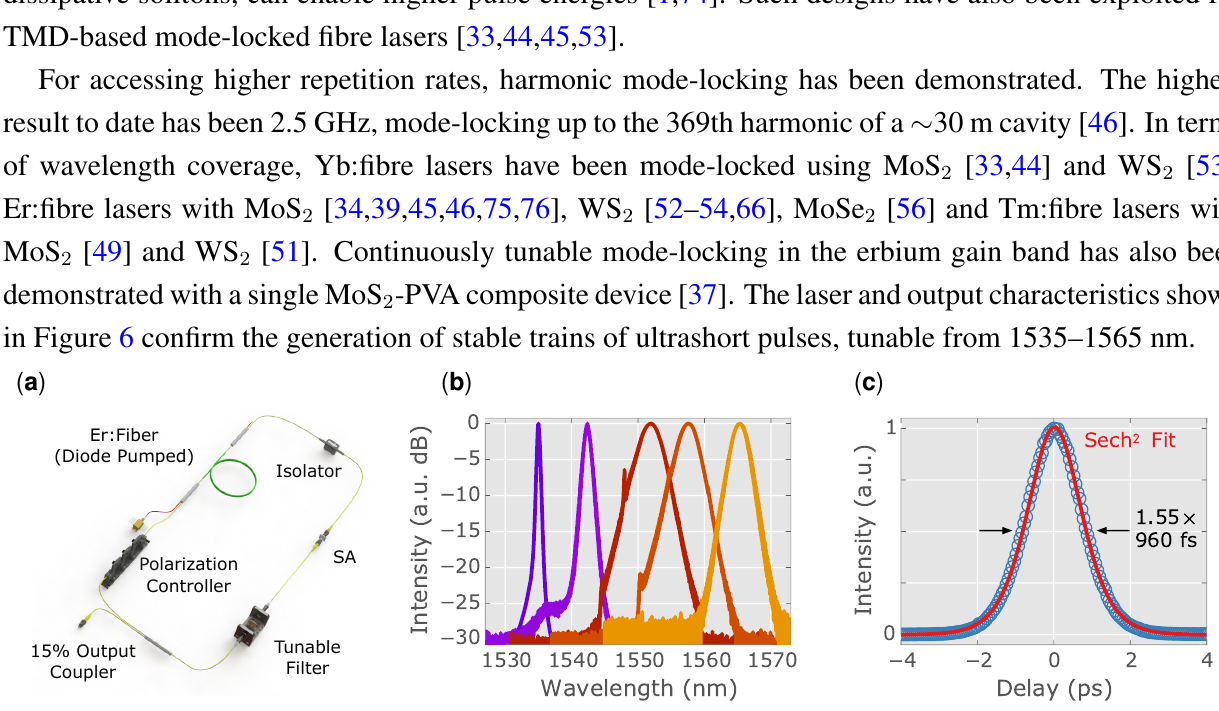
Figure 6. Tunable mode-locked Er:fibre laser using MoS after [37]: ( a ) cavity schematic; ( b ) examples of optical spectra from the continuous tuning range of 1535–1565 nm; ( c ) autocorrelation trace at 1552 nm (assuming sech 2 -shaped pulses, the deconvolution factor is